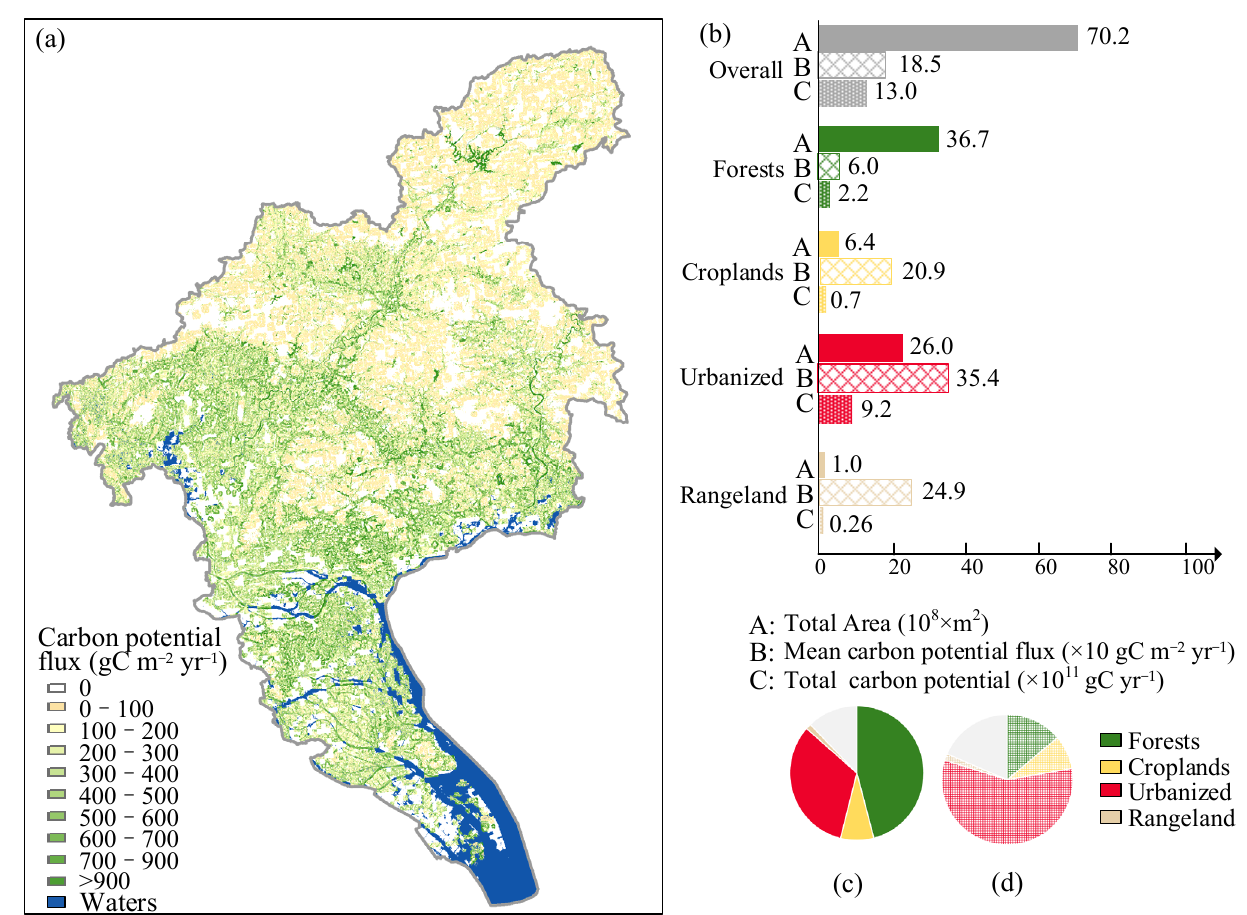
Figure 5. Distribution of carbon uptake potential and its variations among the land cover classes. ( a ) the flux of potential of carbon uptake, ( b ) the carbon uptake potential from different land cover classes, ( c ) area of the land cover classes, ( d ) contribution of carbon uptake potential among the land cover classes.